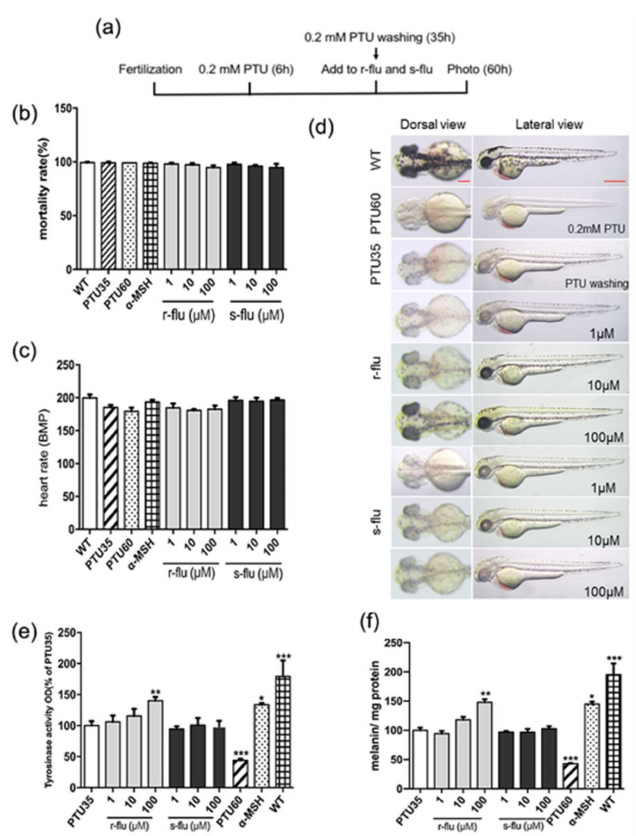
Figure 3. Effect of r/s-fluoxetine on tyrosinase activity and melanin synthesis in zebrafish. ( a ) Schematic representation for the schedule of pigmentation rescue study. ( b ) Mortality rate was calculated by calculating the normally developed embryos at various concentrations for 48 h. ( c ) The heart-beating rate was measured at 60 hpf (hours post-fertilization), under the stereomicroscope. ( d ) Synchronized embryos were treated with 0.2 mM 1-phenyl-2-thiourea (PTU) at 6 hpf. r-fluoxetine and s-fluoxetine was added and incubated for a further 25 h, after a PTU wash, at 35 hpf. Scale bar, 200 µ m. ( e ) Tyrosinase activity and ( f ) melanin contents of about thirty synchronized embryos, collected and dissolved in cold lysis buffer. After centrifugation, 10 µ g of the total protein was incubated with 0.1% of L -dopa, as described in Section 4. All experiments were repeated three times. Data were analyzed by one-way analysis of variance (ANOVA), followed by a post hoc Tukey test. Bars indicate the means ± SEM of the three independent experiments. * p < 0.05, ** p < 0.01, *** p < 0.001, compared with the PTU35 (control).